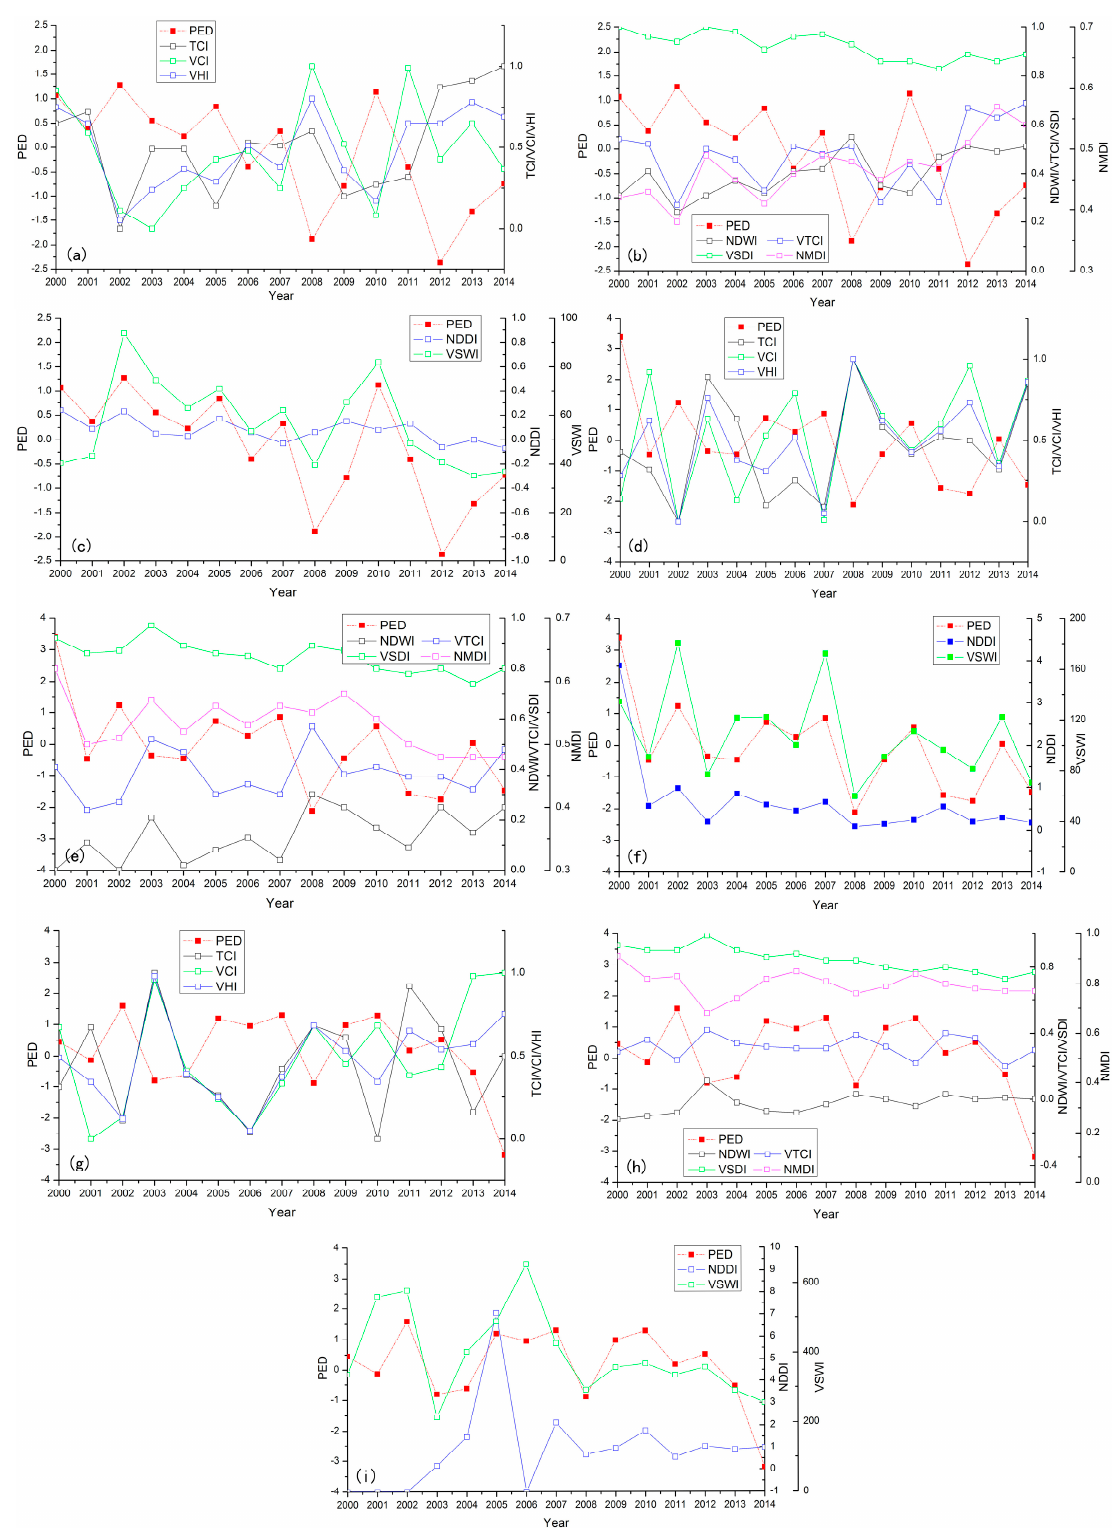
Figure 3. Time series plots of nine RS-derived drought indices and the PED in first 10 days of July from 2000 to 2014 for the following three classes: ( a – c ) forest steppe; ( d – f ) steppe; ( g – i ) desert steppe.